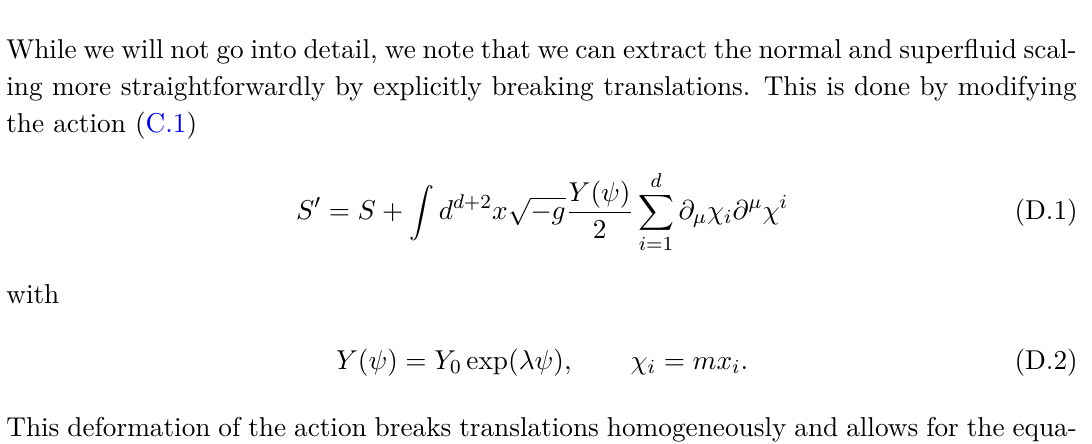
+ # T 2 , ρ n ∼ ρ (0) n + # T 2 .